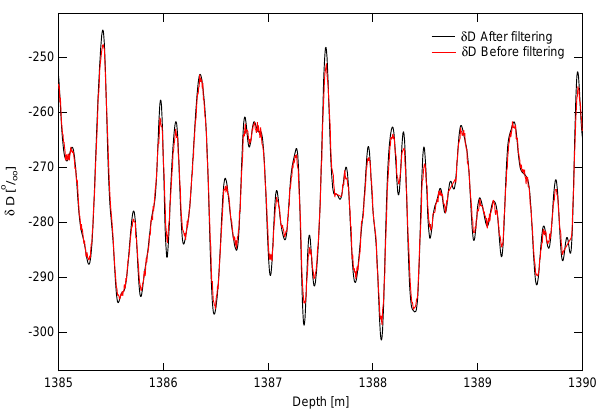
Fig. 10. δ D signal before and after optimal filtering. Fig. 11. δ